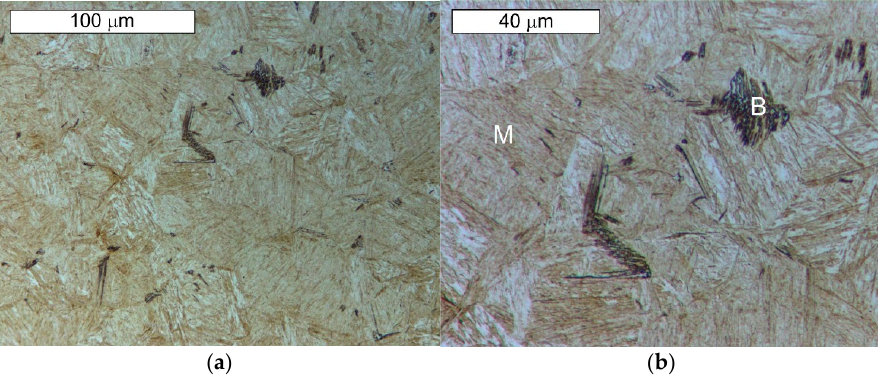
Figure 7. Microstructure of the examined Hardox steel obtained from sample 1: ( a ) visible tempered martensite (M) with locally occurring bainite (B); ( b ) magnified fragment of the area from Figure 7a. Light microscopy, etched state.